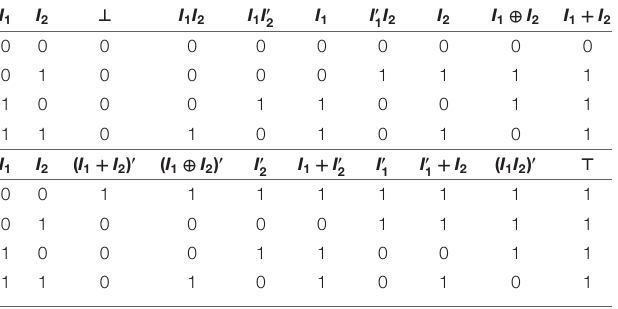
TABLE 1 | Truth tables for all the sixteen possible two-input logic functions expressed in Boolean variables (0 and 1).